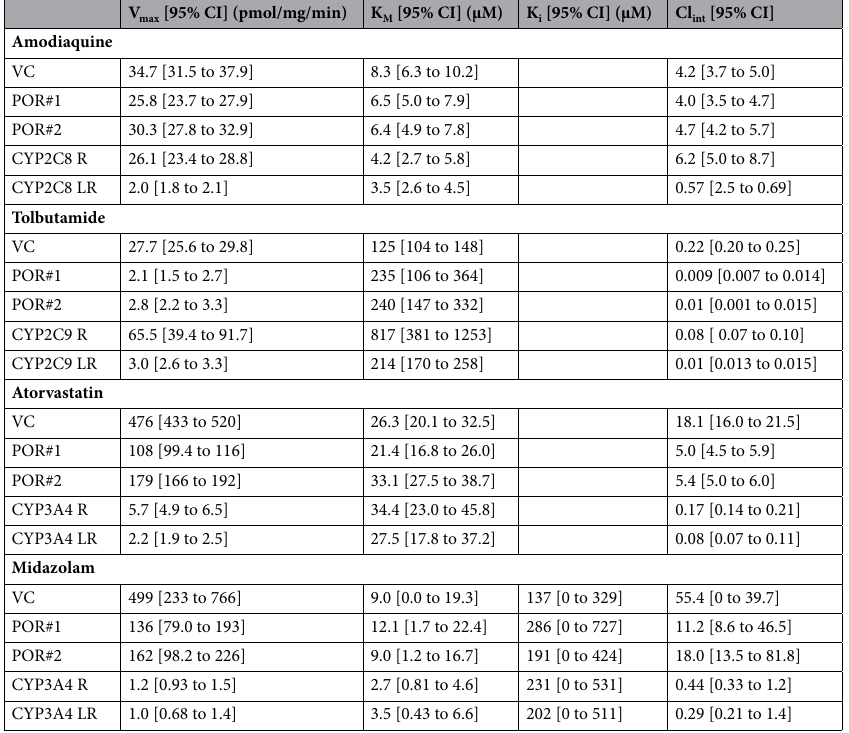
Table 2. Calculated kinetic parameters of selected substrate conversions. Substrates were incubated at different concentrations with microsomal fractions of HepaRG cells transduced with vector control (VC) or sgRNA POR#1, POR#2 or with bacterial membrane vesicles containing recombinant CYP2C8, CYP2C9 and CYP3A4 coexpressed with high (R) or low (LR) levels of POR. Following metabolite quantification by LC–MS/ MS, kinetic parameters K M and V max were determined by Michaelis–Menten model or by substrate inhibition model, and K i was determined by one site competition model. Internal clearance (Cl int ) was calculated using V max this equation: Cl int = K M . Results are shown with 95% CI given in brackets. See Figs. 3 and 4 for further